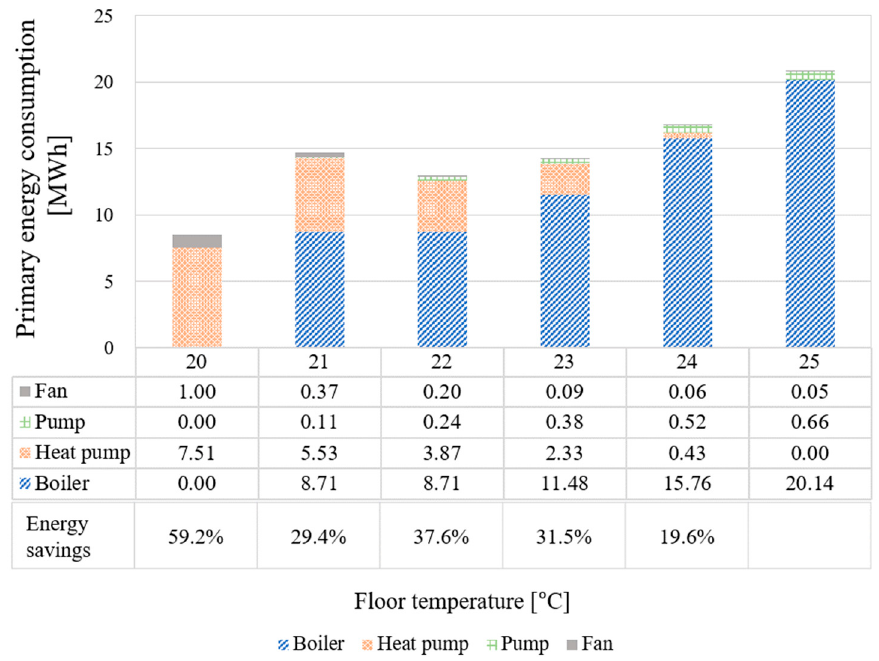
Figure 4. Primary energy consumption of the systems with variation in floor temperature.